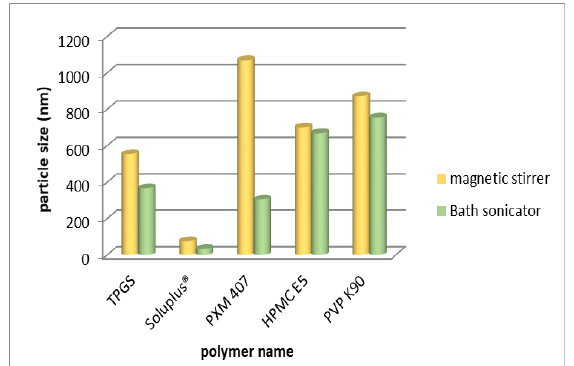
Figure 4. The effect of using Bath sonicator